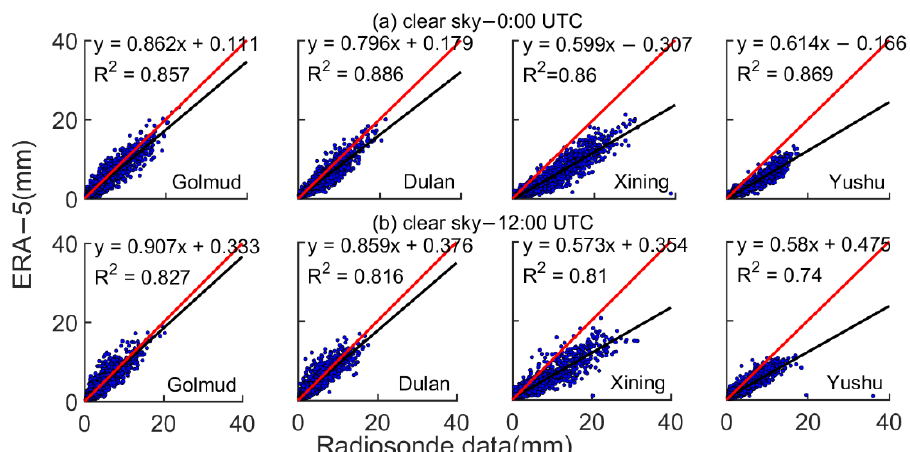
Figure A1. Multi-year mean total cloud cover in the study area. ( a ) AIRS data. ( b ) ERA-5 data.